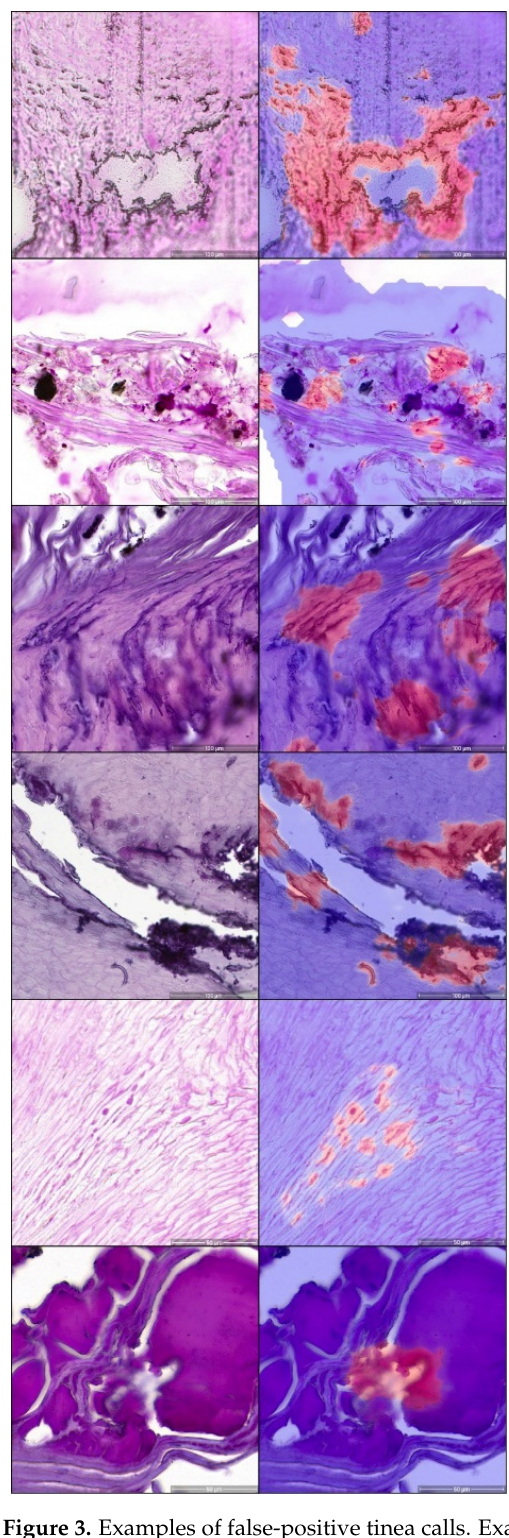
Figure 3. Examples of false-positive tinea calls. Examples where the algorithm made a call of tinea but was not verified by the majority of dermatopathologists are shown. The left column represents PAS-stained slides; the right picture with a heatmap overlay of the U-NET algorithm. The high amount of staining artifacts, common for difficult-to-process nail material, is apparent, which poses a diagnostic difficulty for pathologists and the algorithm